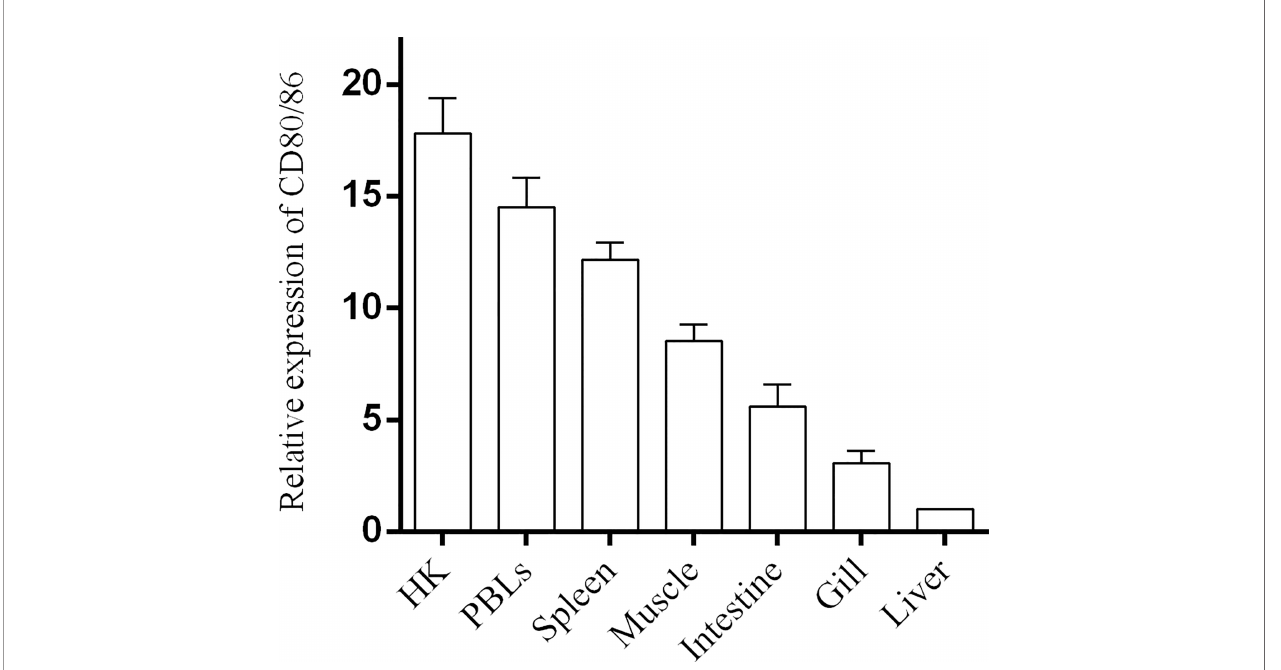
FIGURE 2 | The expression of CD80/86 in fl ounder. The relative expression level of CD80/86 in different tissues was normalized to b -actin and then compared with the average expression level in the liver in which the expression level was lowest and de fi ned as 1, n =